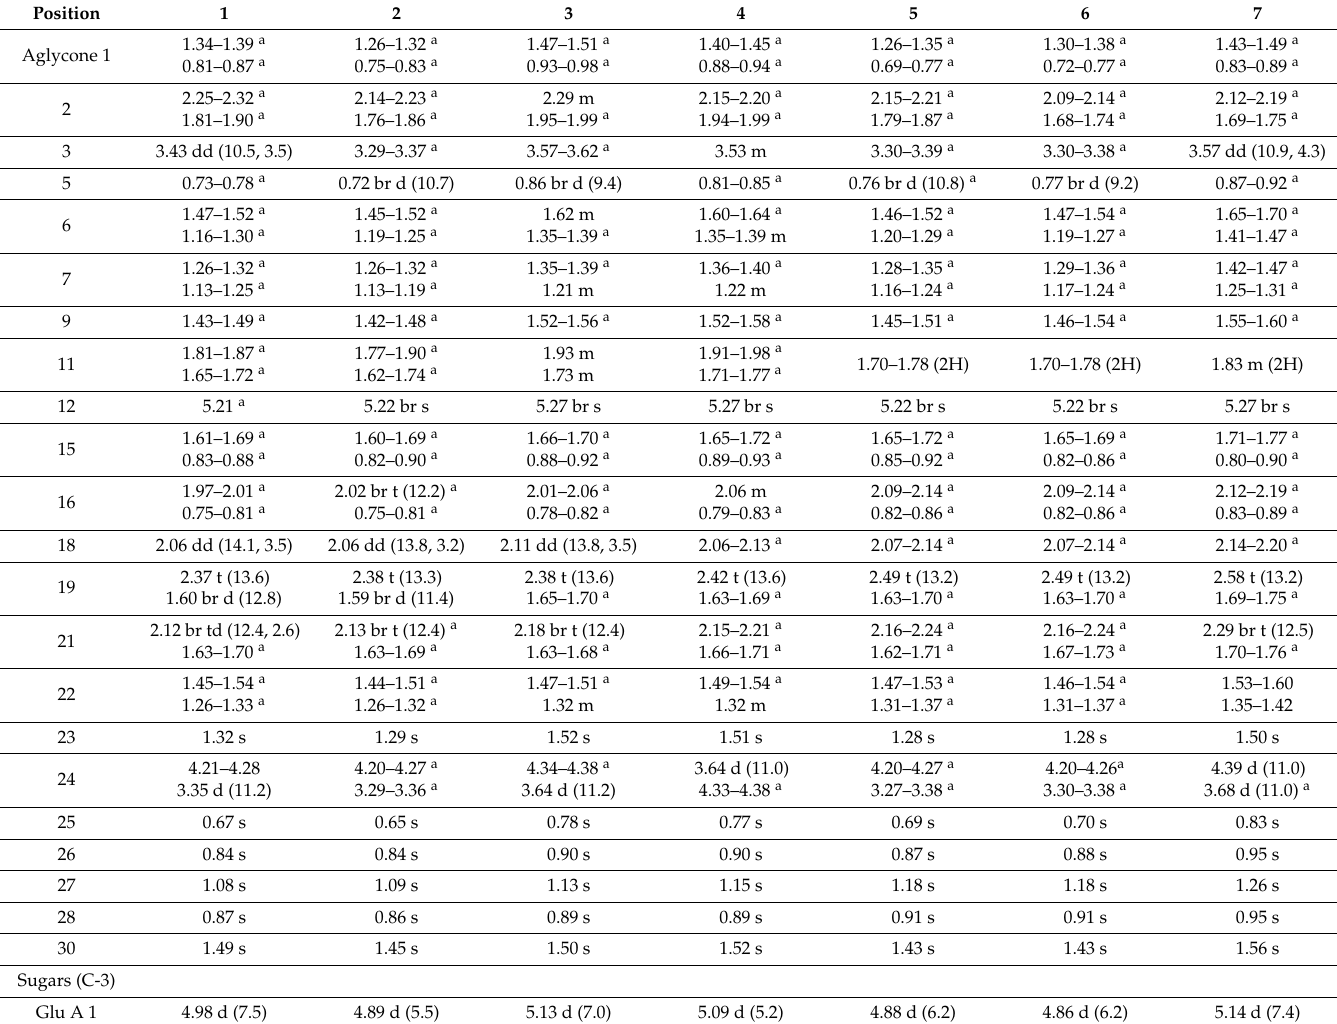
Table 1. 1 H NMR Data for Compounds 1 – 7 in Pyr- d